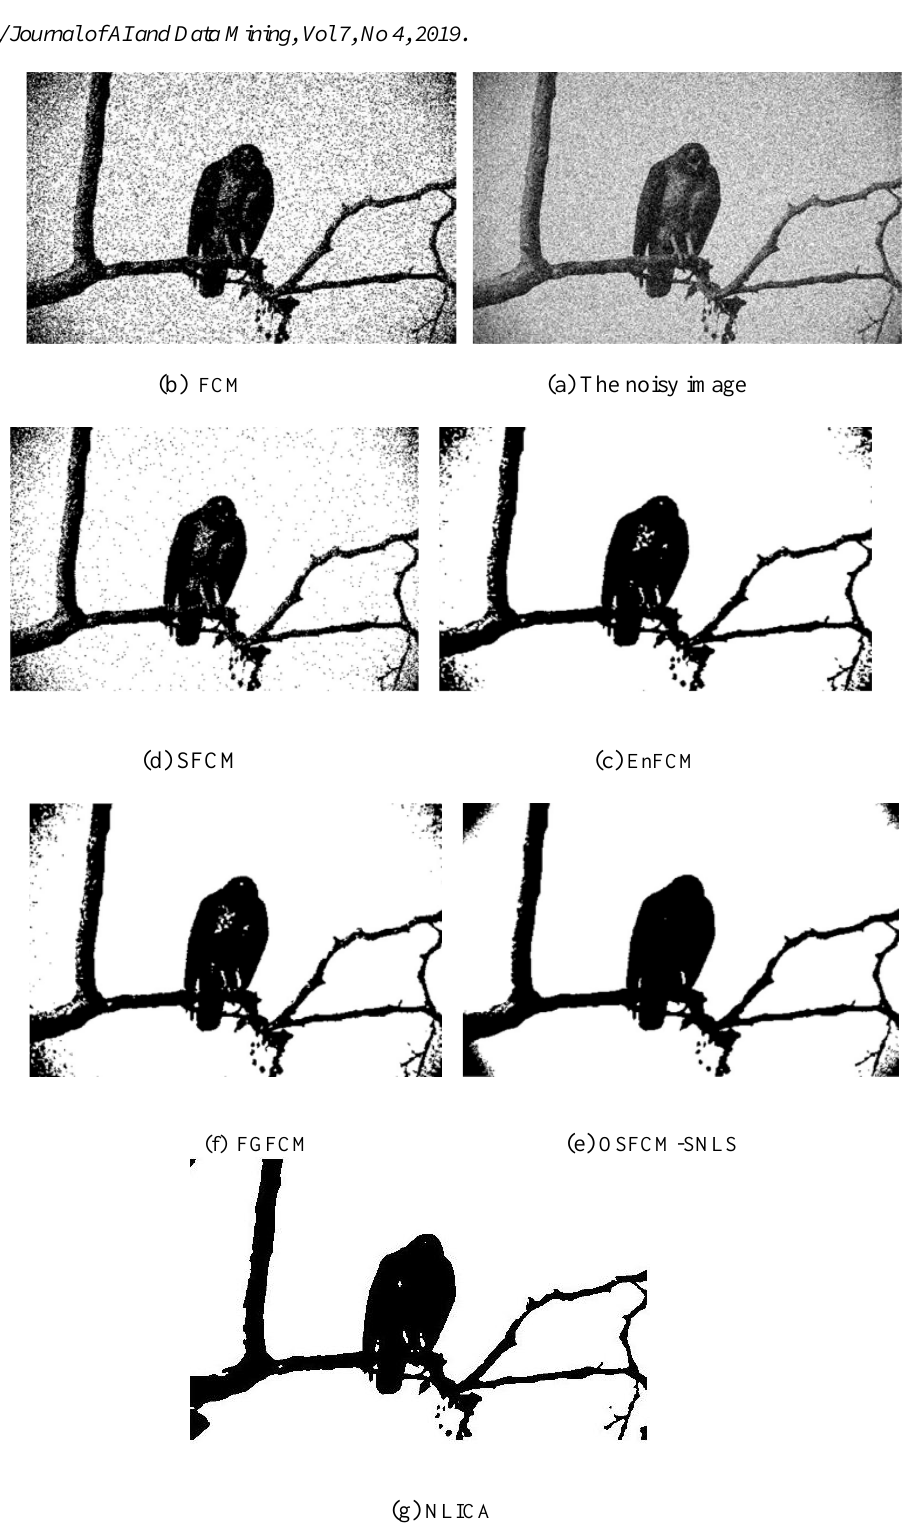
Figure 10. Segmentation results of image #42049 using different